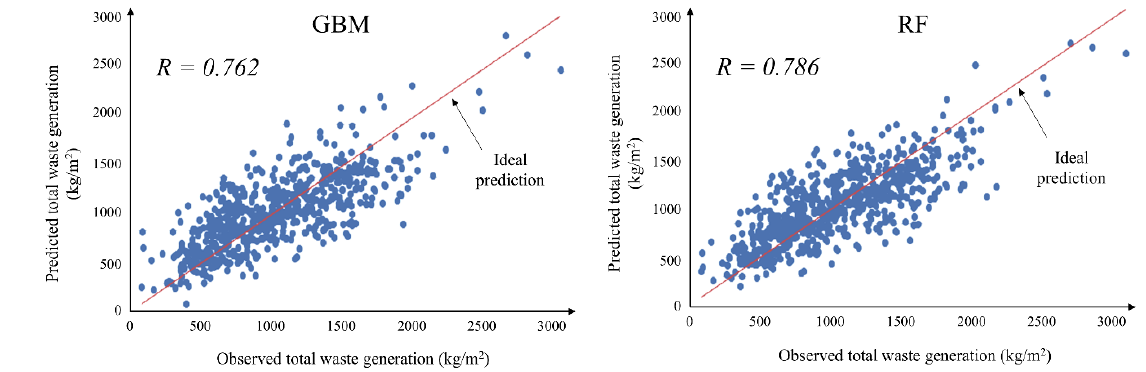
Figure 5. Scatter plot of the observed and predicted total DW generation rate including all waste types using GBM and RF.